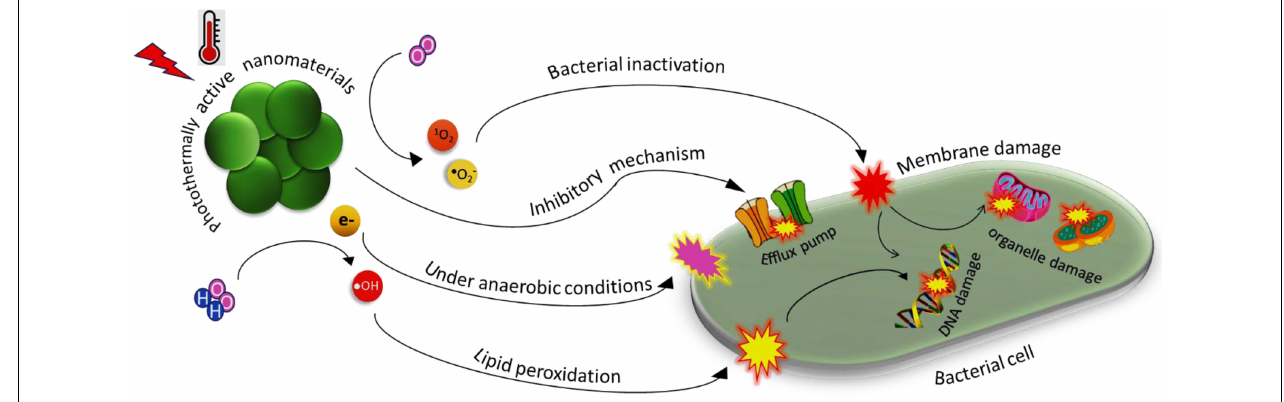
FIGURE 2 | Antibacterial potency of photothermally active nanomaterials via inducing the generation of reactive oxygen species for targeting cell membranes and their